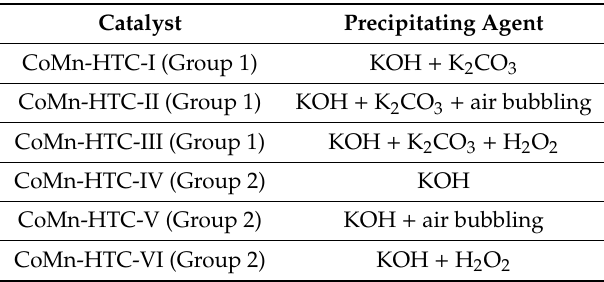
Table 3. Catalyst preparation